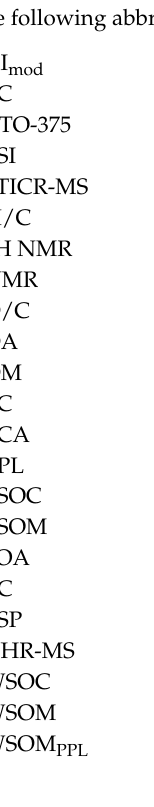
Figure S1: Van Krevelen diagrams for molecular formulas identified in the FTICR mass spectra for the marine, biomass burning, urban, and mixed source aerosols. Each row represents a different source, and each column represents only those formulas with a specific elemental makeup (CHO, CHON, or CHOS). Each “ ˆ ” represents one or more molecular formulas. Figure S2: The loadings for (a) PC1 and PC2 and (b) PC1 and PC3 from the PCA analysis of the FTICR-MS molecular formulas. Figure S3: Venn diagrams showing the relative distribution of PCA molecular formulas present in any of the three solvent/ionization methods (WSOM ´ , WSOM+, and PSOM) for each aerosol source. Areas of overlap represent percentages of molecular formulas that appear in two or more of those samples. Areas with no overlap represent the percentage of molecular formulas unique to that individual solvent/ionization